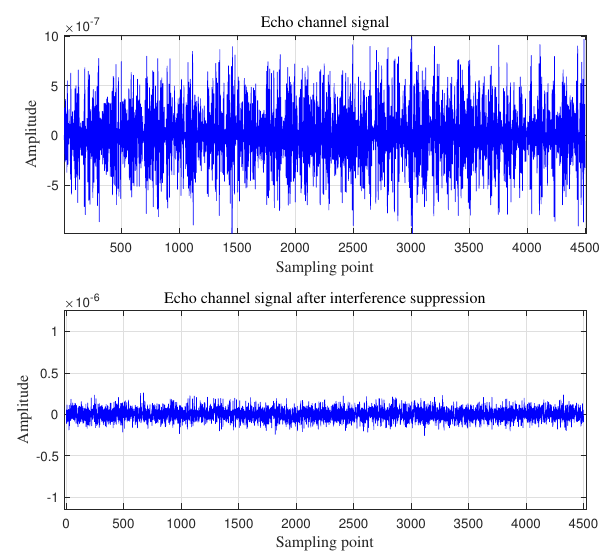
Figure 10. Time-frequency two-dimensional correlation graph with unsuppressed interference.